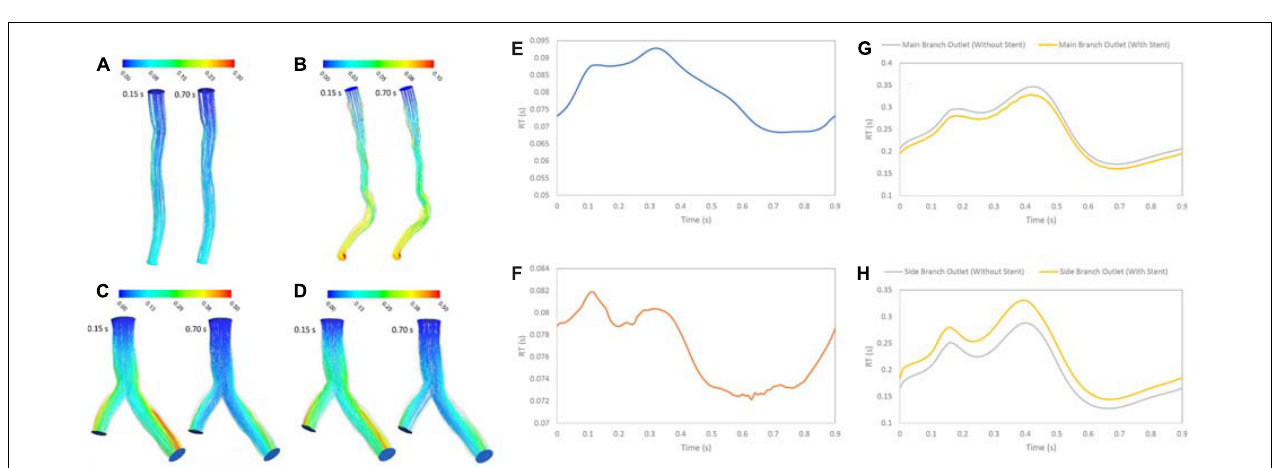
FIGURE 5 | LNH isosurfaces (A) for patient A and (B) for patient B (C) for patient C without stent and (D) with stent during both systole (0.15 s of pulse) and diastole (0.7 s of pulse).